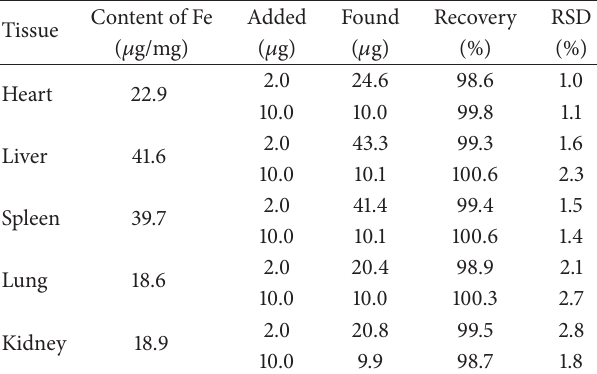
Figure 4: XRD of the glucan-Fe 3 O 4 nanoparticles. Table 1: The recovery of atomic absorption spectrometry method ( 𝑛 = 5